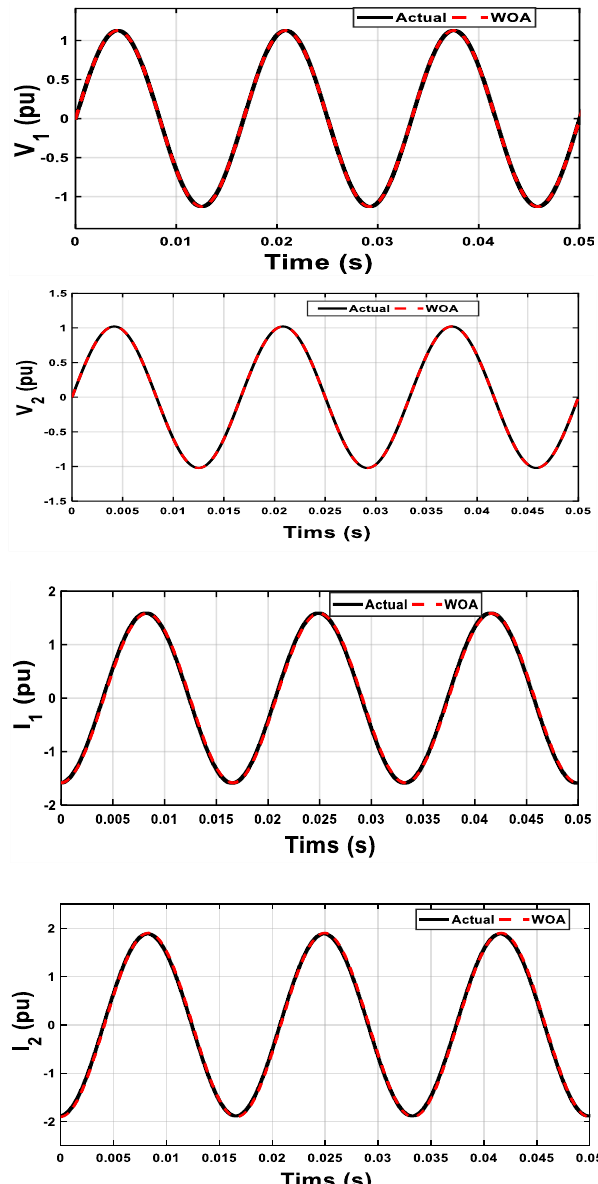
Figure 5. Voltages and currents waveforms at both ends of the TL from case study-1. 297 Table 3. Actual and estimated parameters with ±10% magnitude error in V 2 and I 2 and 20% syn- 298 chronization error.